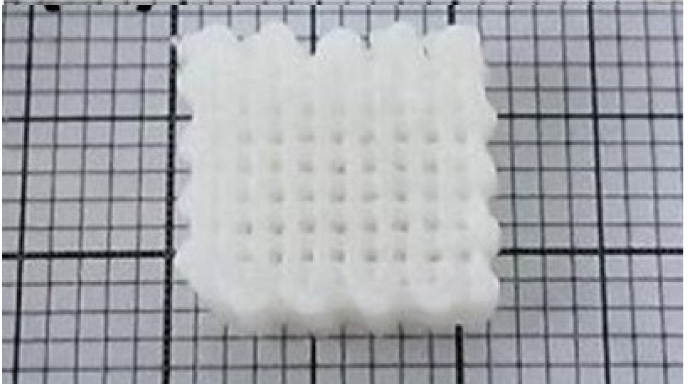
Figure 5. Printed grid structure based on HYH–HAP bioink. Reproduced with permission